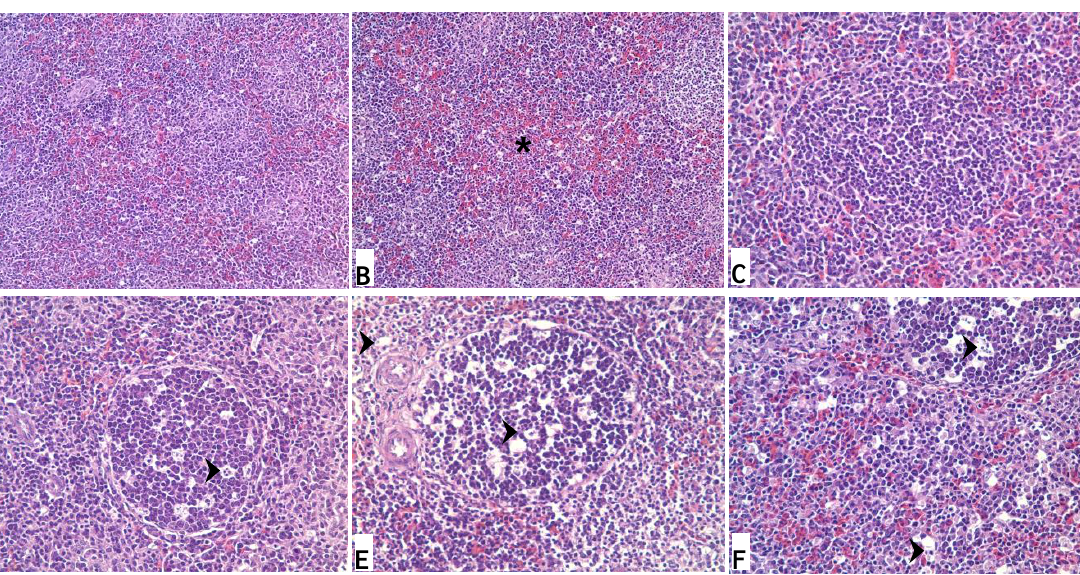
Figure 3. Photomicrographs of hematoxylin and eosin stained chicken spleen section. ( A ) shows the normal histological structure of control group; ( B ) shows that congestion of red pulp (*) is obvious in 100% group. At 21 days of age, when compared with those of control group ( C ), nuclear debris and vacuoles (arrows) are gradually increased in the spleen of chickens in 50%, 75% and 100% groups ( D – F ,